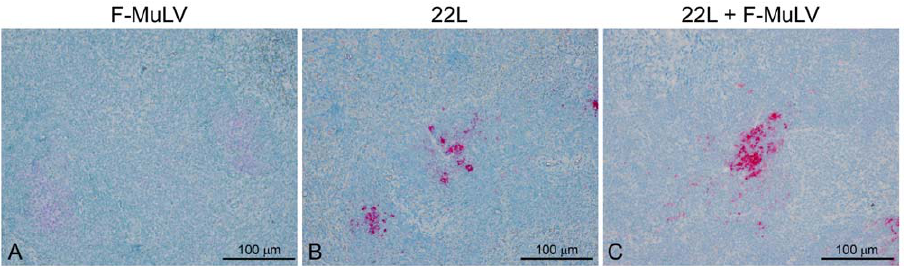
Figure 4. PrP Sc localization in the spleen is the same in mice infected with 22L or 22L plus FV. PrP Sc in spleens from (B10 X A.BY)F1 mice inoculated i.v. with FV alone (A), i.p. with mouse 22L mouse scrapie alone (B), or co-infected with 22L mouse scrapie i.p. and FV i.v. (C). Sections were stained using the anti-PrP mouse monoclonal antibody D13. Magnification=200 6 .